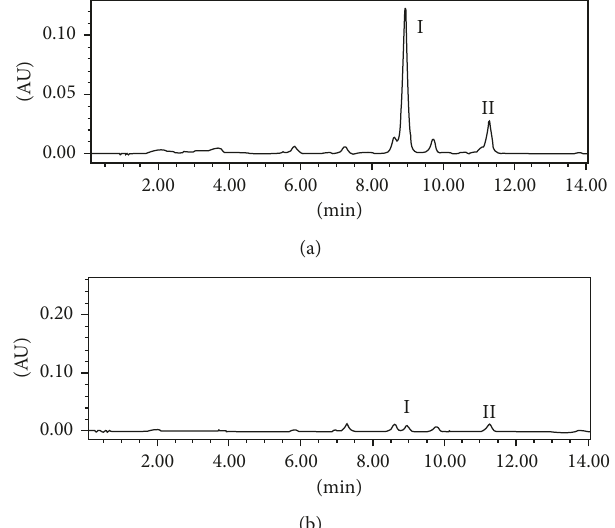
Figure 3: (a) HPLC chromatogram of the ethyl acetate extract from A. officinarum Hance; (b) HPLC analysis of the ethyl acetate extract from A. officinarum Hance after spiking with DPPH. Experimental conditions: column, Inertsil-ODS-SP column (150 × 4.6 mm I.D., 5 μ m); column temperature, 25 ° C; mobile phase, 0.2% acetic acid- acetonitrile with the gradient (0–5min, 55–68% B; 5–15min, 68% B; 15–30min, 68–75% B); flow rate, 1.0mL/min; detection, 254nm; injection volume, 20 μ L.